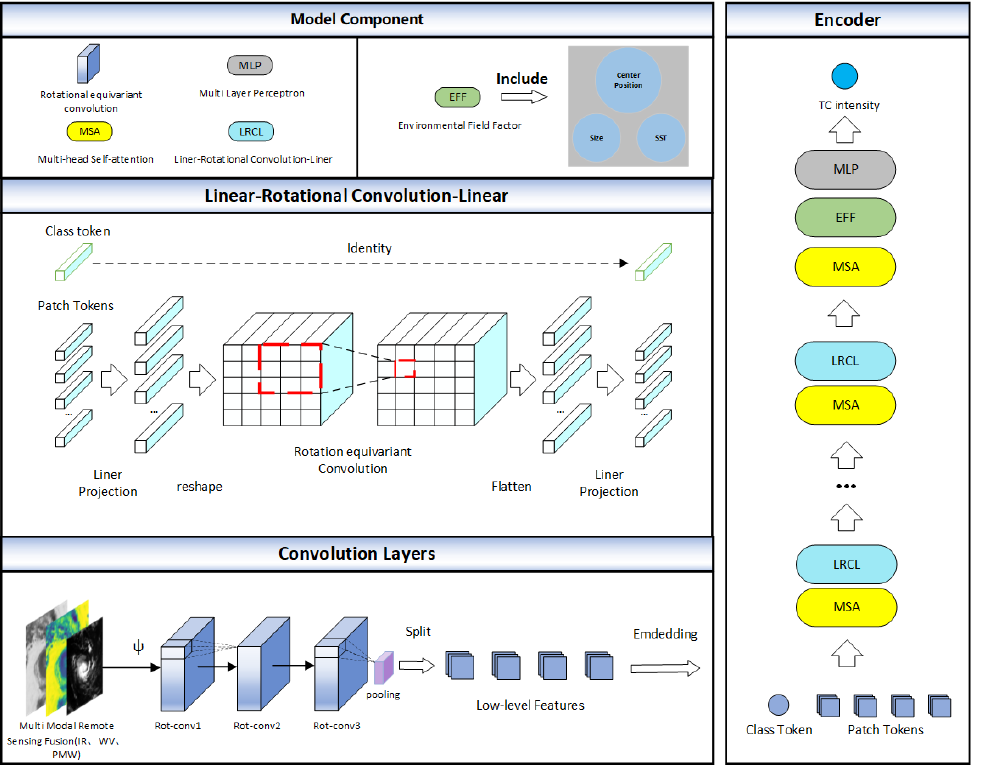
Figure 2. Overall architecture of the model used in this study. Table 4. Parameters of the TCICVIT model. “k3s2” represents a convolutional kernel size of 3 and a stride of 2; “REConv” rotation equivariant convolution; “e” represents the expansion ratio, and “k” represents the kernel size of the REConv in the corresponding